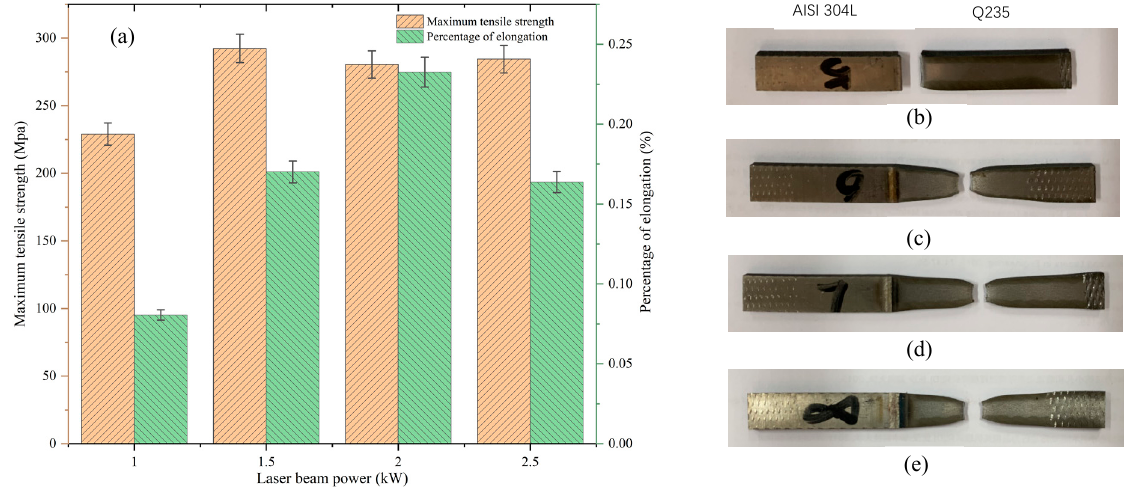
Figure 12. The tensile strength curves and fractured positions of samples with different laser power values: ( a ) tensile strength curves; ( b ) laser power = 1 kW; ( c ) laser power = 1.5 kW; ( d ) laser power = 2 kW; ( e ) laser power = 2.5 kW.